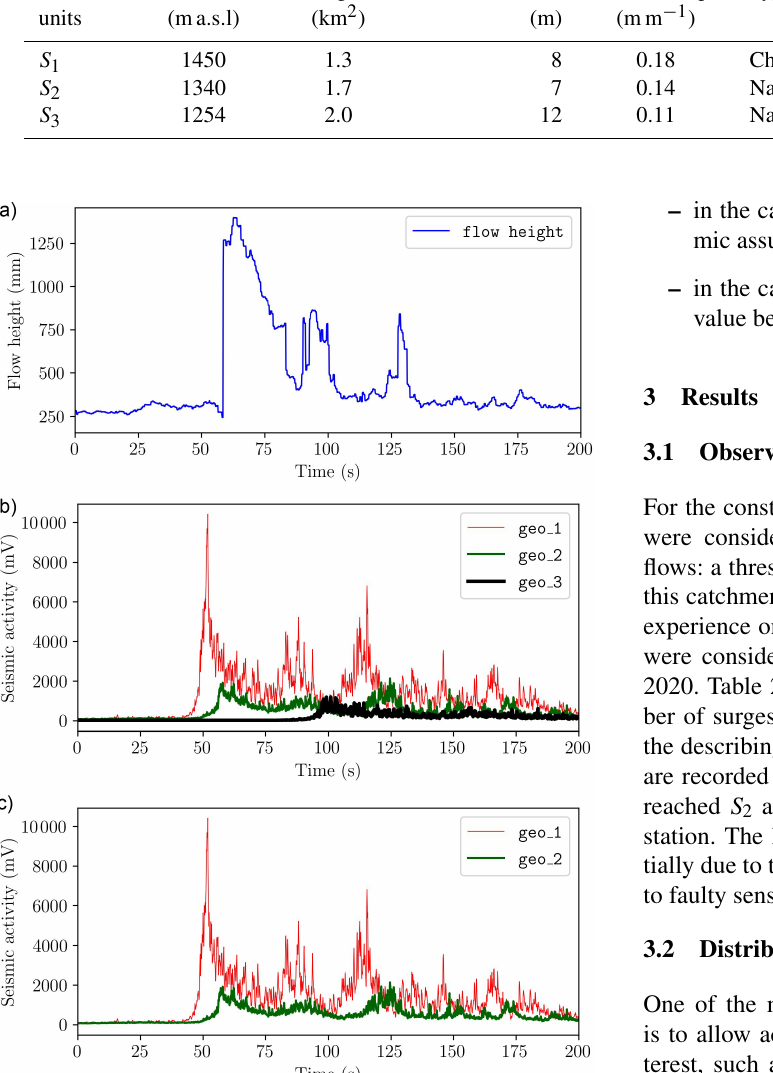
ent points around the station with a frequency of 5 or 10 Hz, (ii) rainfall data every 5 min (not used directly in this work), (iii) flow height with a frequency of 5 or 10 Hz, and (iv) im- agery of the event (when possible) with a 0.2 or 1 Hz fre-